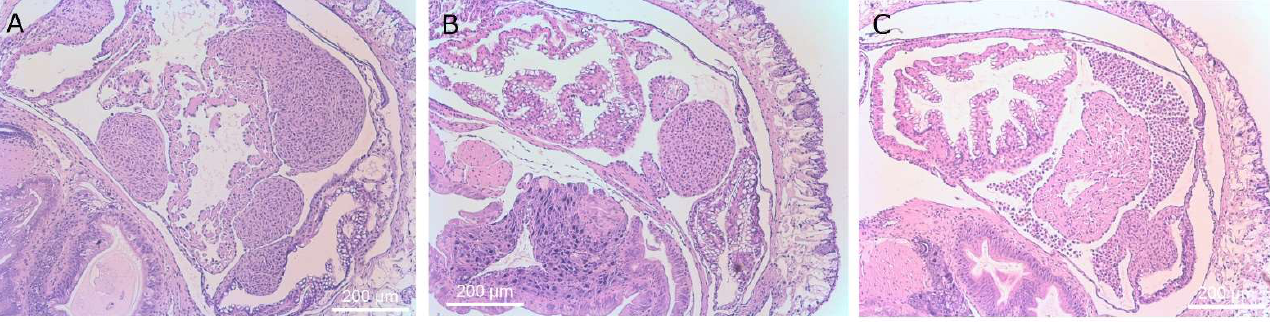
Figure 13. Histological sections of slugs showing masses of inflammatory cells. Images ( A , B ), × 40 mag. These structures are formed from the epicardial cells of the heart and kidney. Image ( C ) shows aggregating hypertrophic amoebocytes, × 40 mag.